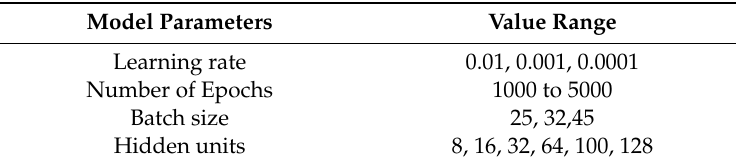
Table 6. Model parameters and their